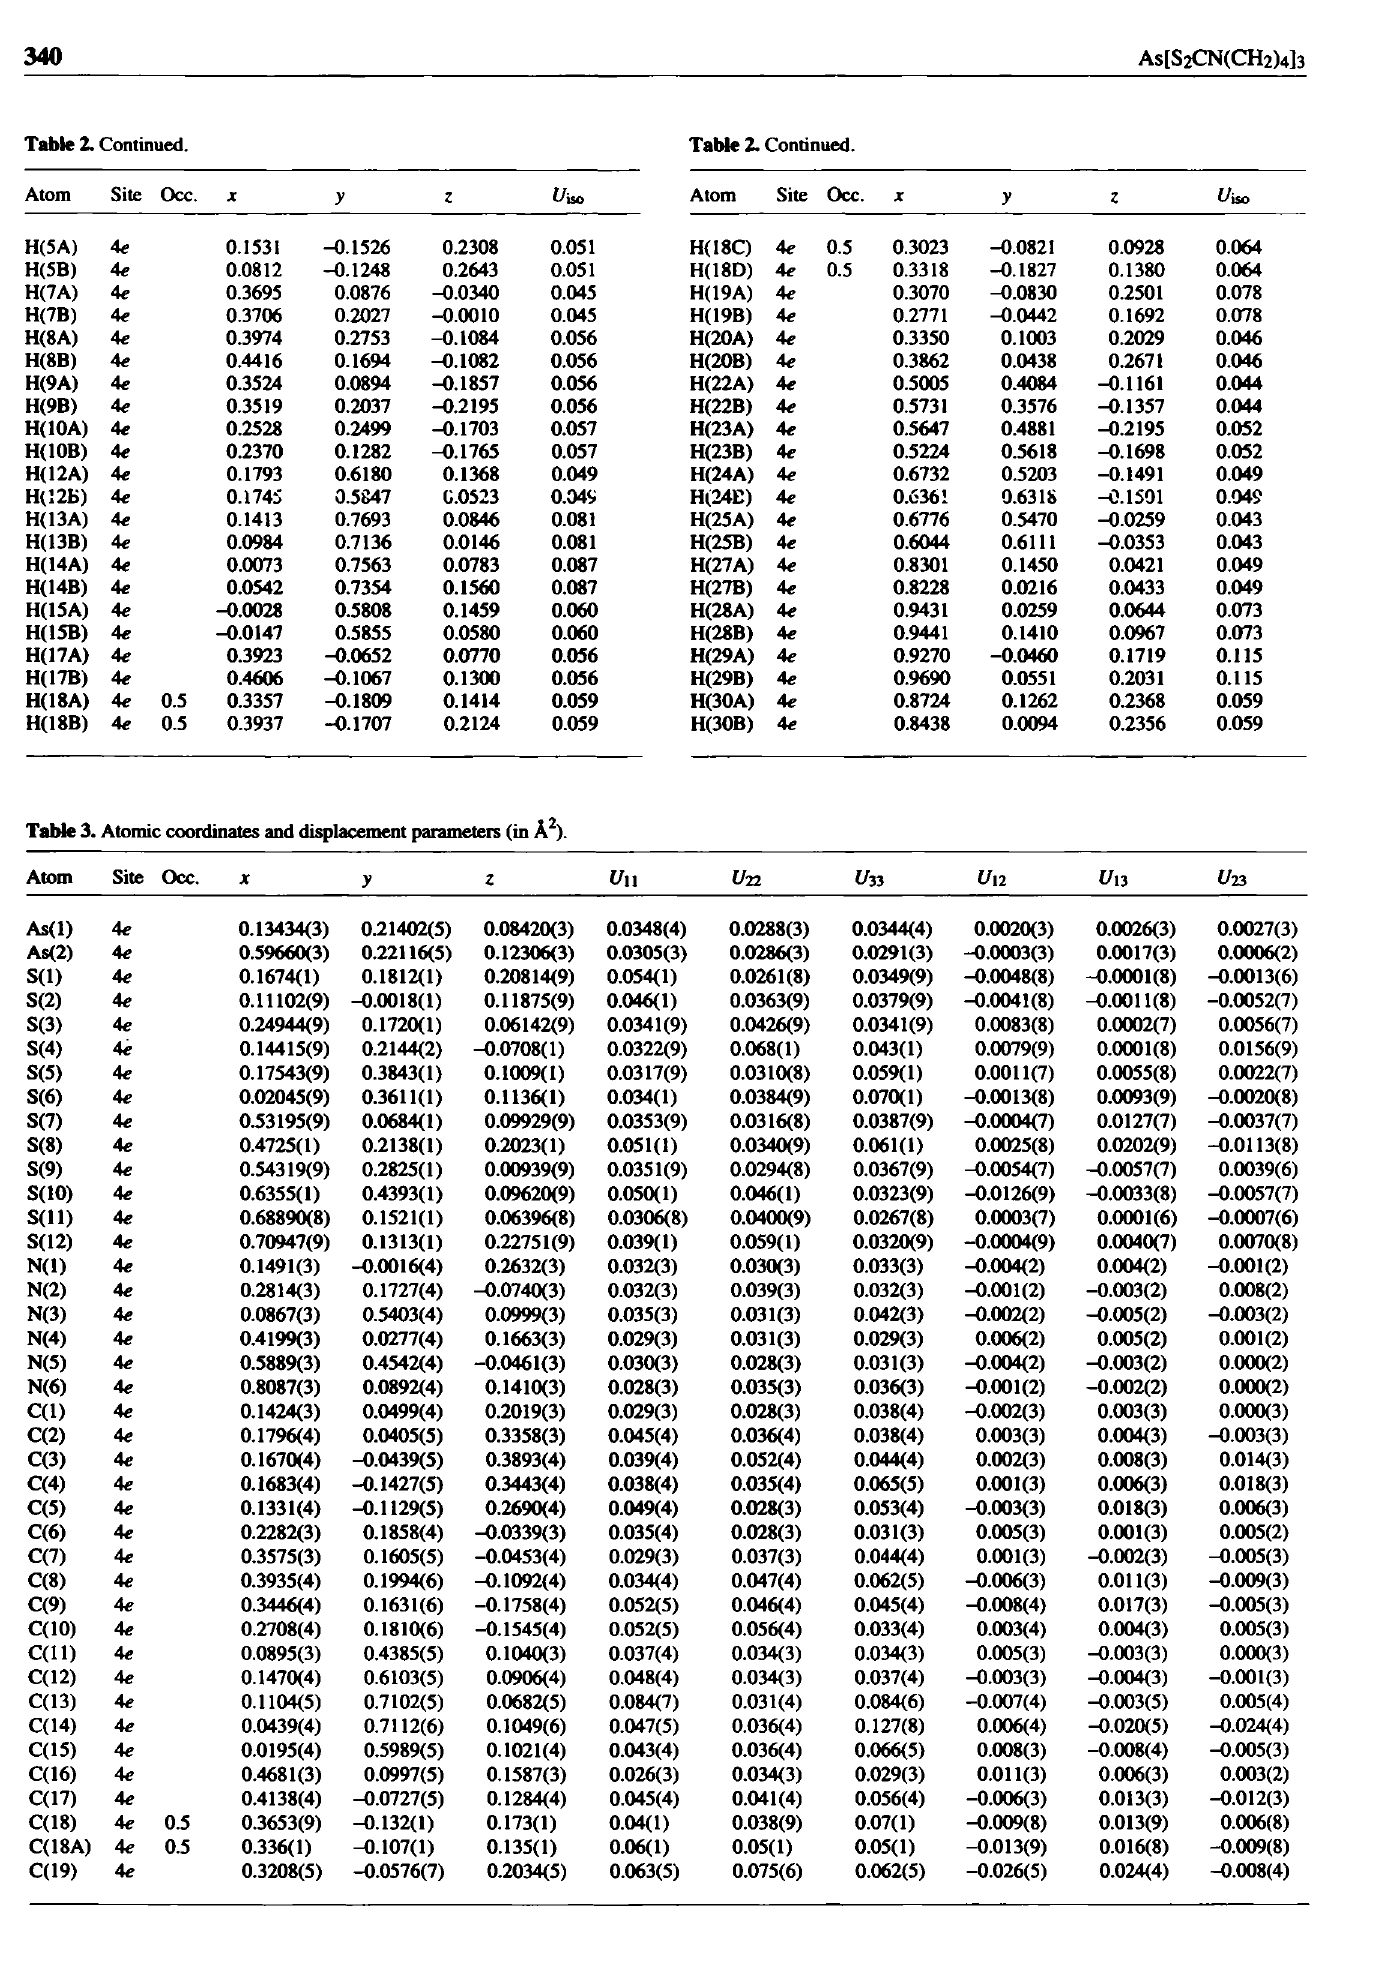
Table 3. Atomic coordinates and displacement parameters (in A 2